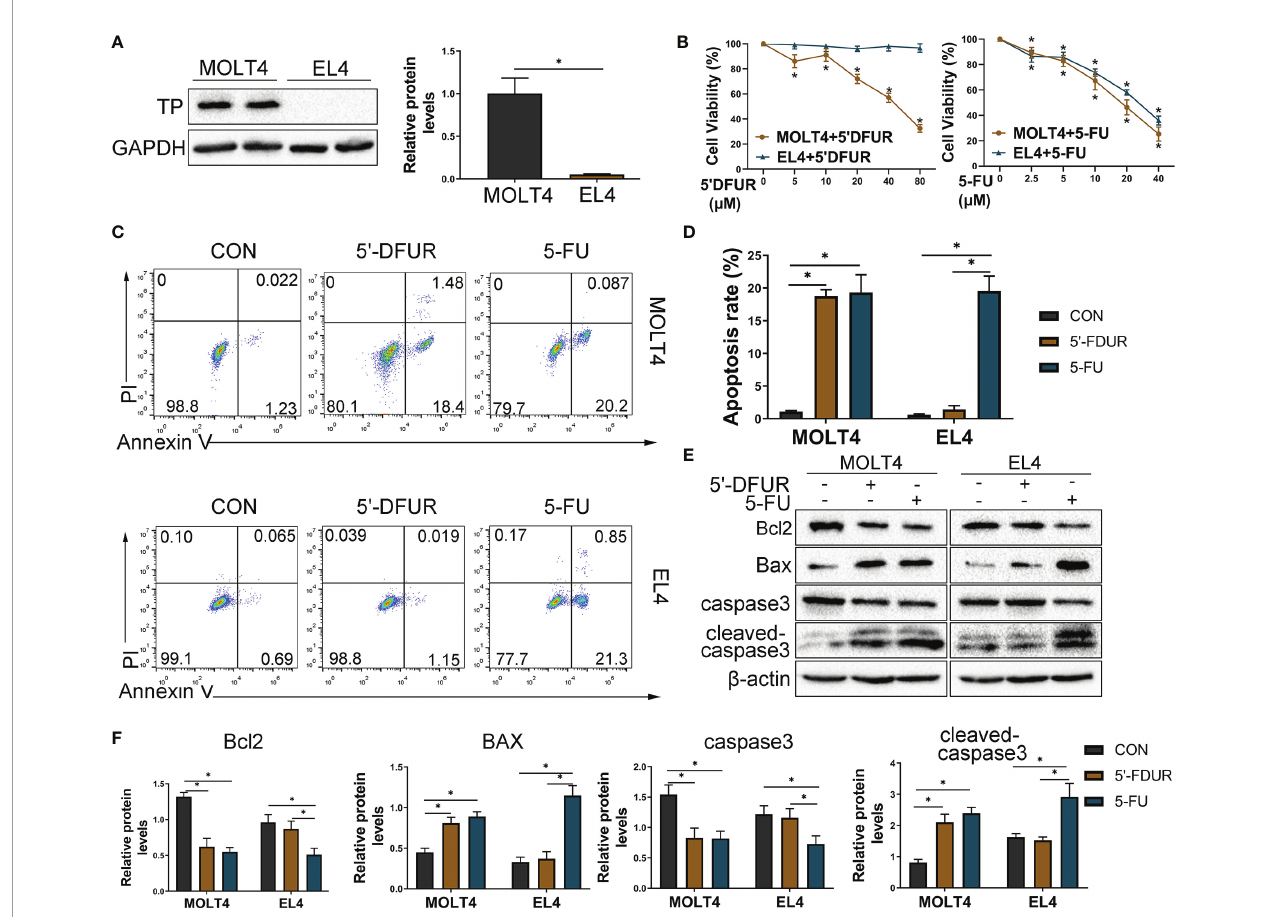
FIGURE 5 | Differential expression of TP in T cells affects CAP-induced apoptosis in vitro . T cell lines (EL4 and MOLT4) were selected for further research in vitro , and we chose 5 ′ DFUR (conversion to 5-FU depends on TP) and 5-FU, both of which are intermediate metabolites of CAP, instead of CAP for the in vitro experiments. (A) TP protein levels in EL4 and MOLT4 cells were detected by western blot analysis. (B) Viability of EL4 and MOLT4 cells exposed to gradient concentration of 5 ′ -DFUR or 5-FU for 48 h was measured by CCK8 test. (C, D) According to IC50, EL4 and MOLT4 cells were exposed to 5 ′ -DFUR (0 m M and 50 m M) or 5-FU (0 m M and 30 m M) for 48 h; apoptosis of T cells was detected by Annexin V/PI staining. (E, F) The protein levels of apoptosis-related proteins, including caspase3, Bcl2, and BAX, were evaluated using western blot assay. Data are shown as mean ± SD. * P <